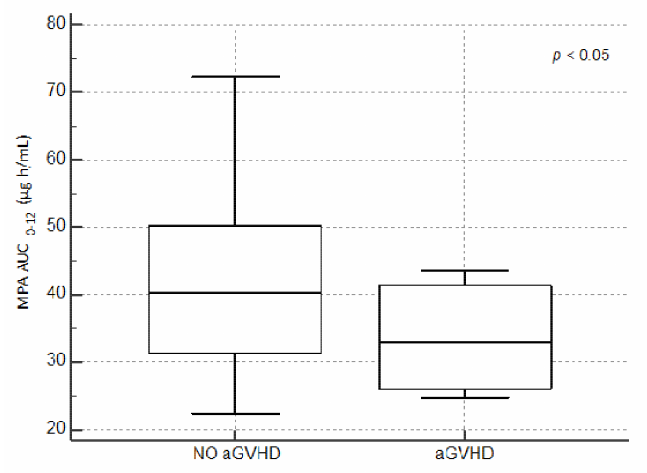
Figure 4. Effect of the last mycophenolic acid (MPA) area under the curve (AUC 0–12 ) concentration on the incidence of acute graft-versus-host disease (aGvHD).